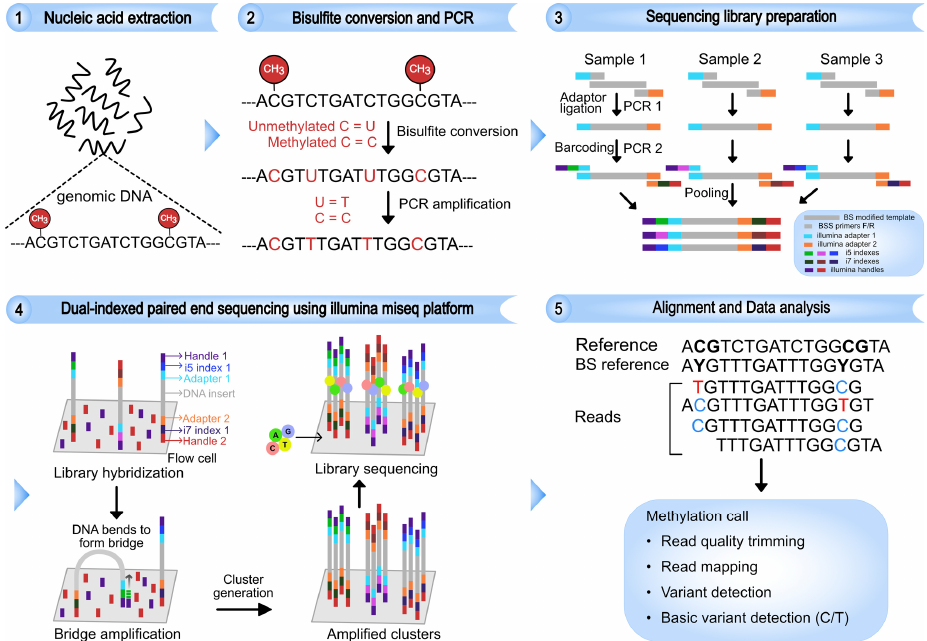
Figure 1. Schematic layout of the next-generation bisulfite sequencing (NGS-BS). The gDNA is iso- lated and modified by bisulfite (BS) treatment, which changes the unmethylated cytosine to uracil while previously methylated cytosine remains unchanged. The converted uracils are amplified as thymine in the PCR step. To simplify the sequencing library generation, the adapter sequences are tagged with the bisulfite-specific primers and the region of interest is amplified by inner PCR (PCR 1). The amplicon generated is barcoded with dual indexes in the outer PCR step (PCR 2), and sam- ples are pooled for multiplexing. The multiplexed libraries are run on next generation sequencer (NGS), and the sequencing reads are aligned to bisulfite reference sequence. The cytosine methyla- tion at each individual CpG position was determined, and methylation percentage is calculated. 2. Materials and Methods 2.1. Patient Samples and Cell Lines Blood samples were collected from 11 healthy individuals and 12 patients positive for HCV RNA and anti-HCV antibodies (HCV + ) at Uppsala University Hospital, Sweden. All subjects gave their informed consent for inclusion before they participated in the study. The study was conducted in accordance with the Declaration of Helsinki, and the protocol was approved by the regional Ethics Committee of Uppsala (Dnr 2016/238). The human Jurkat T cell and three HCV C proteins expressing Jurkat T cell line JHC.d, JHC.g and JHC.h have been characterized before [35] and were cultured in RPMI-1640 media (Sigma-Aldrich, Stockholm, Sweden) supplemented with 10% fetal calf serum and 1% penicillin–streptomycin mixture (Sigma-Aldrich) at 37 °C in a 5% CO 2 incubator. 2.2. PBMC Isolation The patient’s whole blood was diluted with equal volumes of PBS, and Peripheral Blood Mononuclear Cells (PBMCs) were separated from the blood by centrifugation on a Histopaque TM -1077 cushion (Thermo Fisher Scientific, Uppsala, Sweden). PBMCs from the